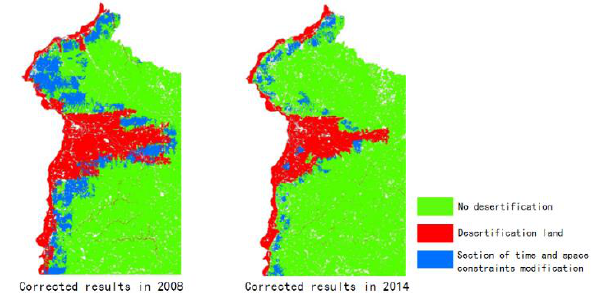
Figure 4. Desertification land extraction results by correction